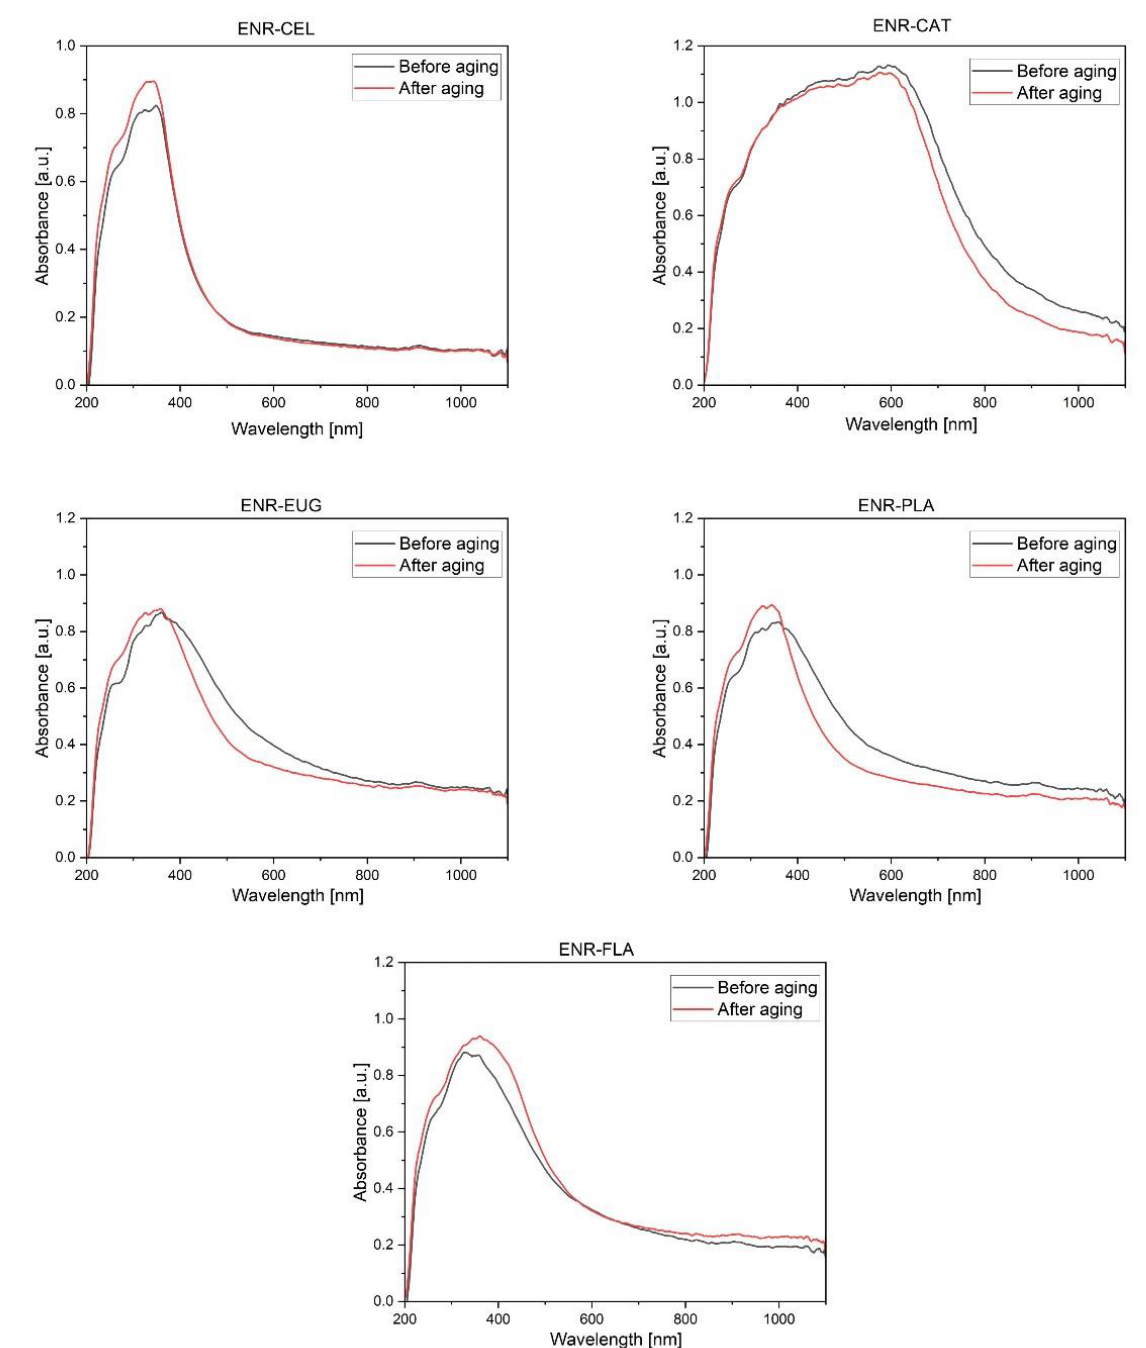
Figure 11. UV-Vis spectra recorded in the range of 200–1100 nm obtained for the studied ENR-based composites with extra content (HPMC, PLA, antioxidants).